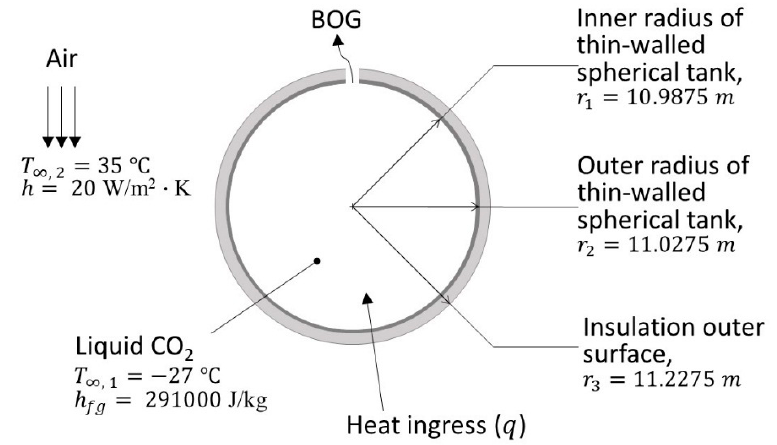
Figure 4. Schematics of simplified storage tank for boil-off gas (BOG) calculation.